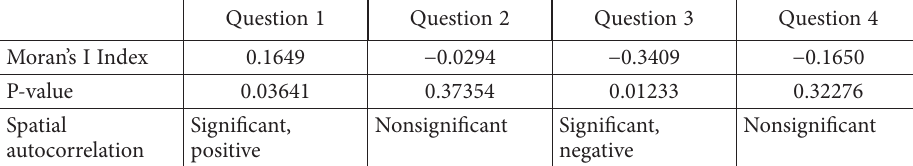
Table 8. Results of spatial autocorrelation testing in case of Czechia (source: own processing)